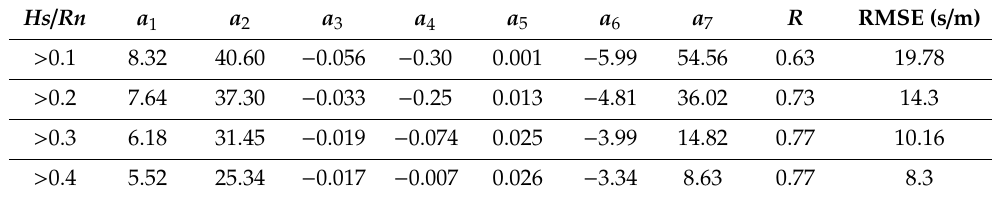
Table 3. Parameterization of r r under di ff erent